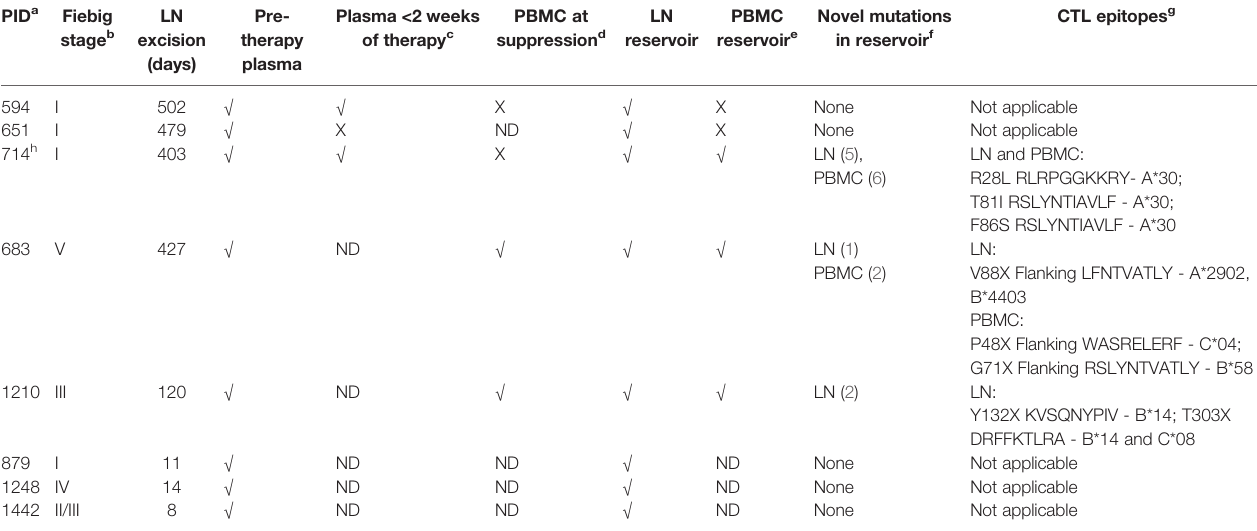
TABLE 2 | Gag sequence differences between the reservoir-derived variants and pre-therapy plasma variants in early treated individuals. PID a